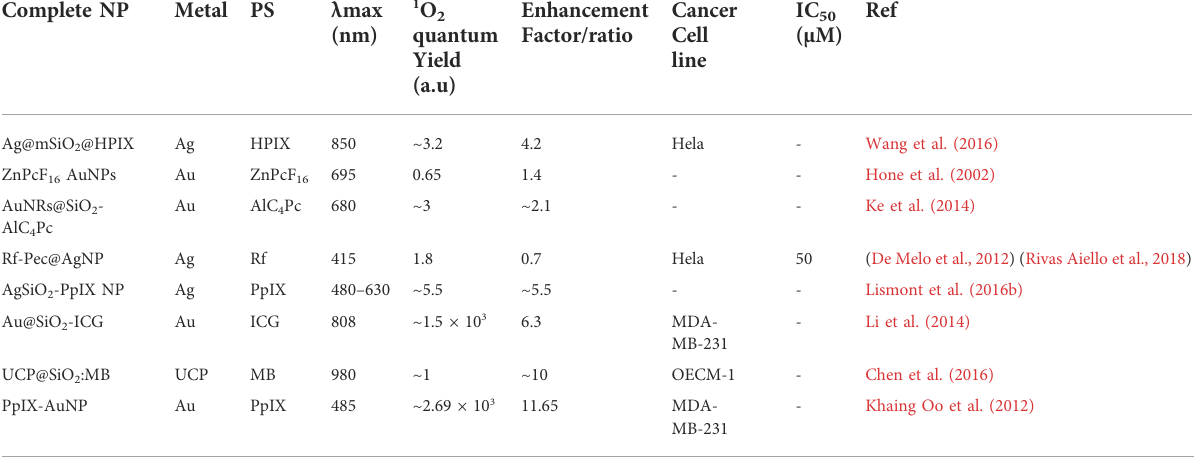
TABLE 1 A summary of examples of metal nanoparticles (NPs) in combination with photosensitizers (PS) and their photophysical properties and PDT enhancement ef fi cacy. Complete NP